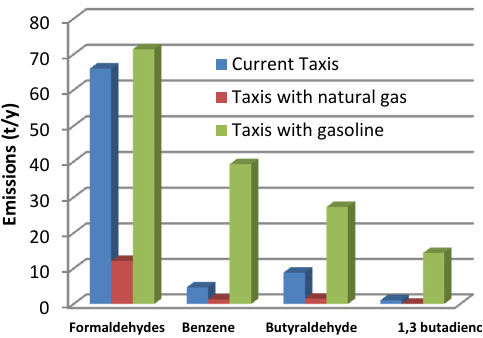
Figure 2. Total unregulated emissions from taxis with different fuels.